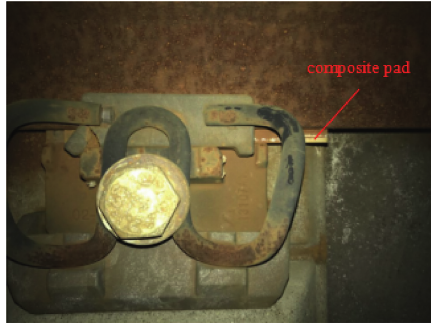
Figure 2: Image of the composite pad sliding.